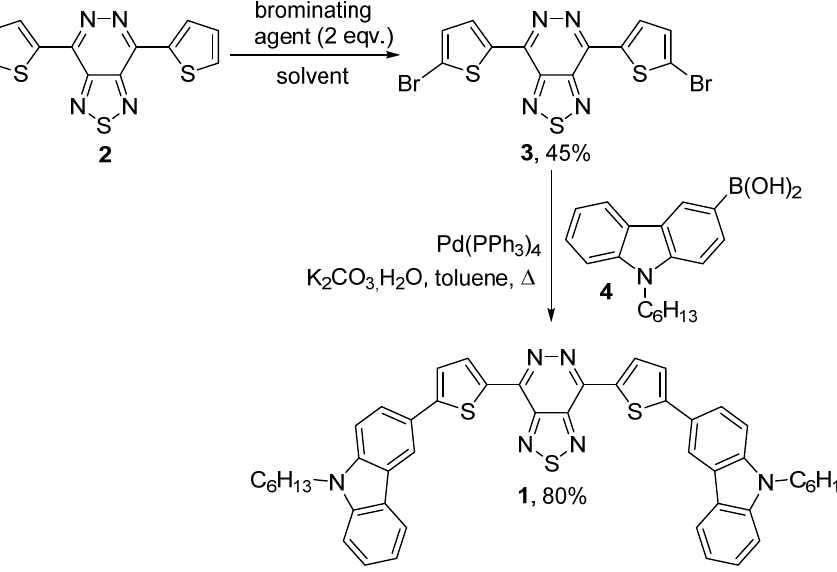
Table 1. Reaction of 4,7-di(thiophen-2-yl)-[1,2,5]thiadiazolo[3,4- d ]pyridazine 2 with brominating agents.